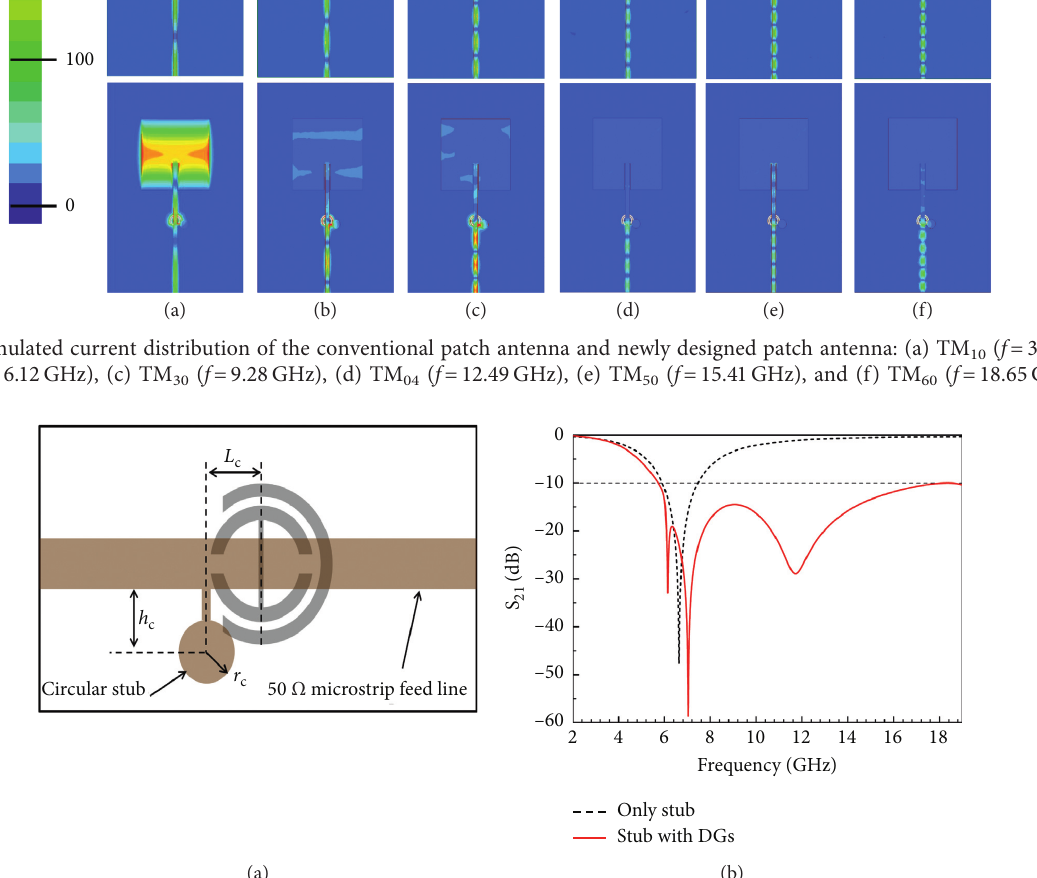
21 for the configurations of only circular stub